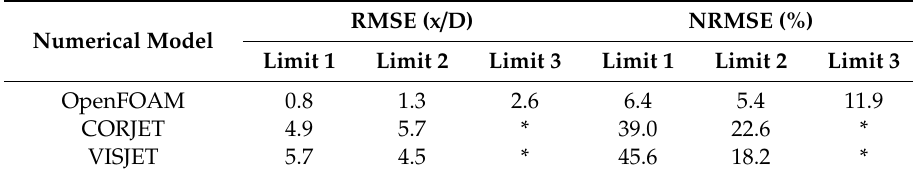
Table 4. Performance of the numerical models to define the limits of positively buoyant jet zones by the metric errors: root-mean square error (RMSE) and normalized RMSE (NRMSE). Numerical